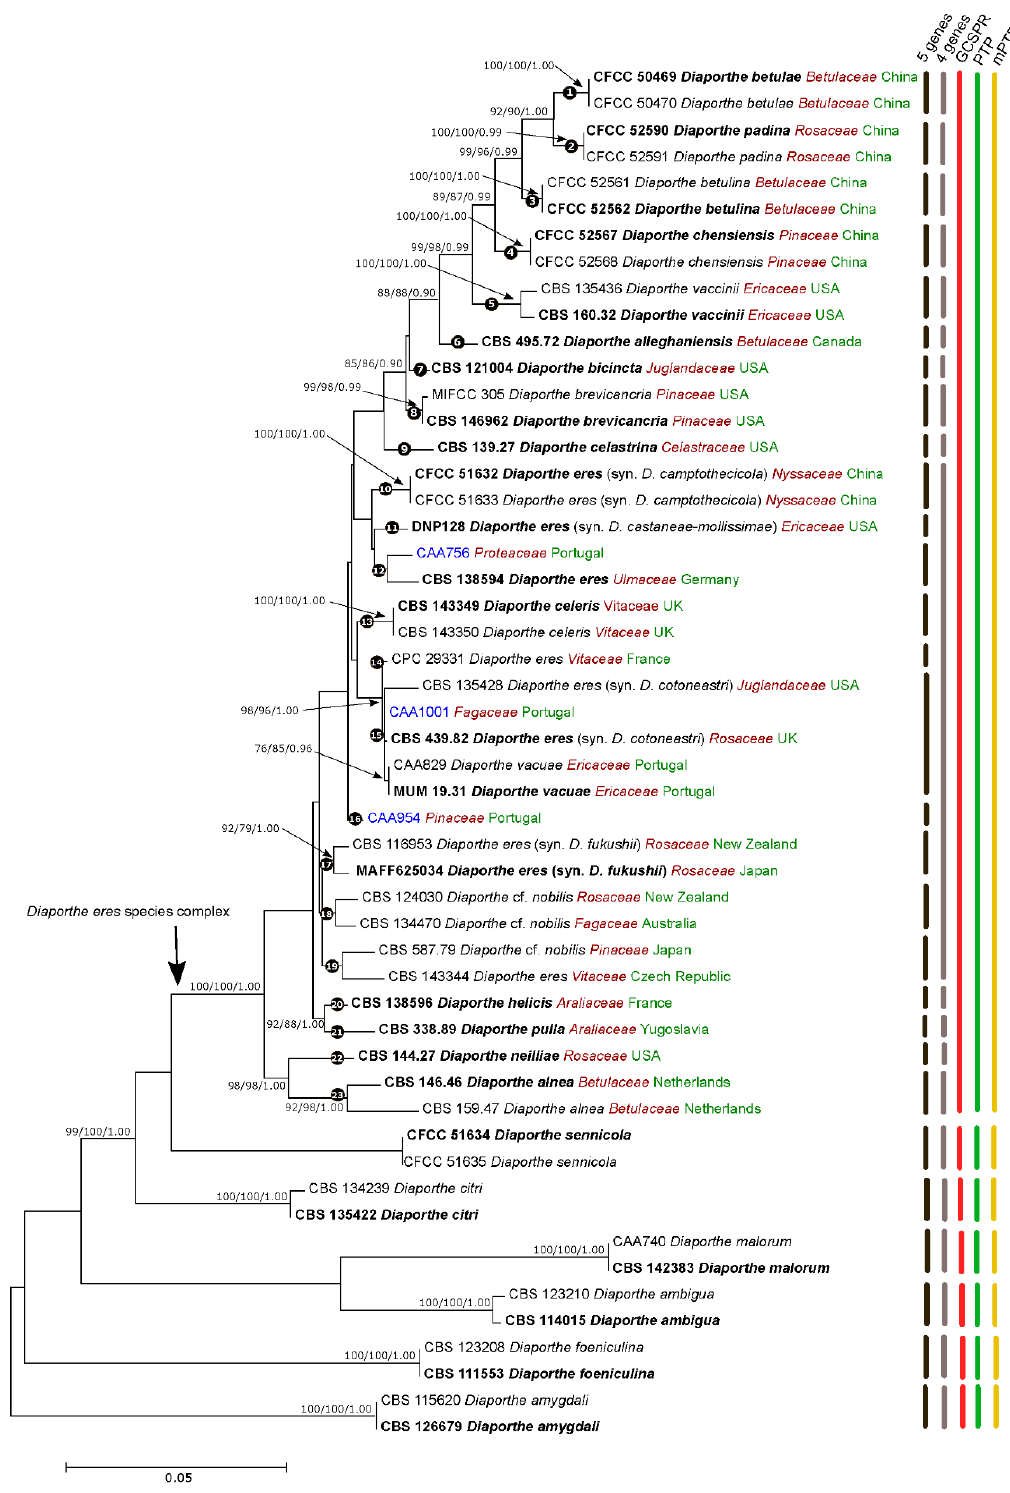
Figure 1. Maximum Likelihood (ML) tree of the Diaporthe eres complex and related species, based on ITS TEF1- α , TUB 2, HIS3 and CAL loci. The ML tree is drawn to scale and was constructed based on the Tamura-Nei parameter model, assuming a gamma distribution. ML and MP bootstrap values greater than 70% and posterior probabilities (PPs) greater than 0.80 are shown at the nodes. The ex-type strains are in bold. The isolates from this study are indicated in blue. Species name is followed by the family of the host it was isolated from (red) and country of origin (green).